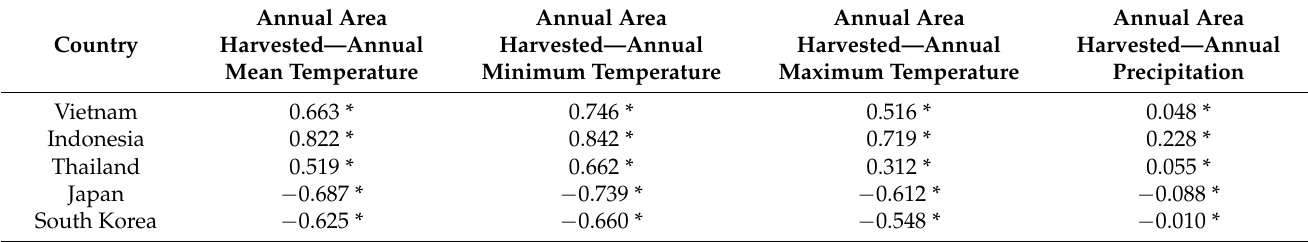
Table 12. Correlation coefficients of climate indicators (annual mean, annual maximum, annual minimum air temperature, and annual precipitation) and area harvested of rice in Vietnam, Indonesia, Thailand, Japan, and South Korea. (Source: data retrieved from